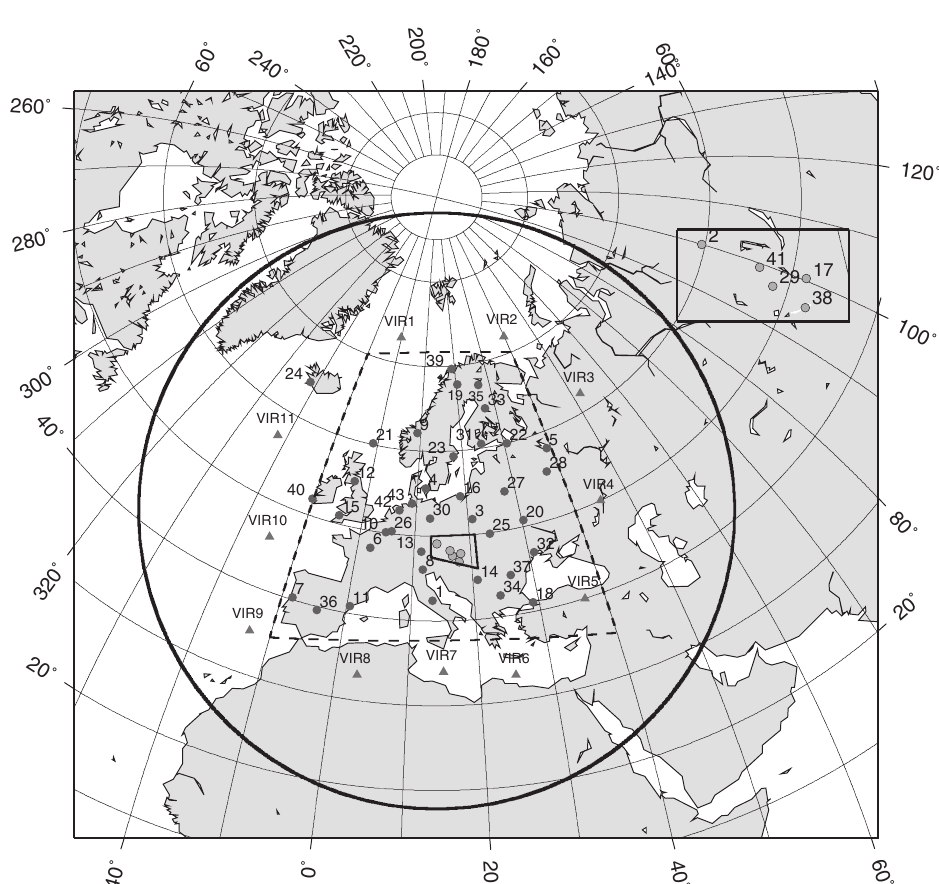
Fig. 1. Locations of the geomagnetic observatories (full circles) and synthetic observatories (triangles) for which synthetic data sets are computed from CM4 model. The geomagnetic observatories are labeled by a num- ber corresponding to the alphabetical order of their IAGA code (see table I). The large circle shows the border of the spherical cap of θ 0 = 35 o used for the SCHA-modeling. The dashed boundary indicates the region of in- terest, over which all maps and animations are produced. The green circles and inset are used to label four close observatories. Equidistant azimuthal projection. al solution of Laplace’s equation in the case